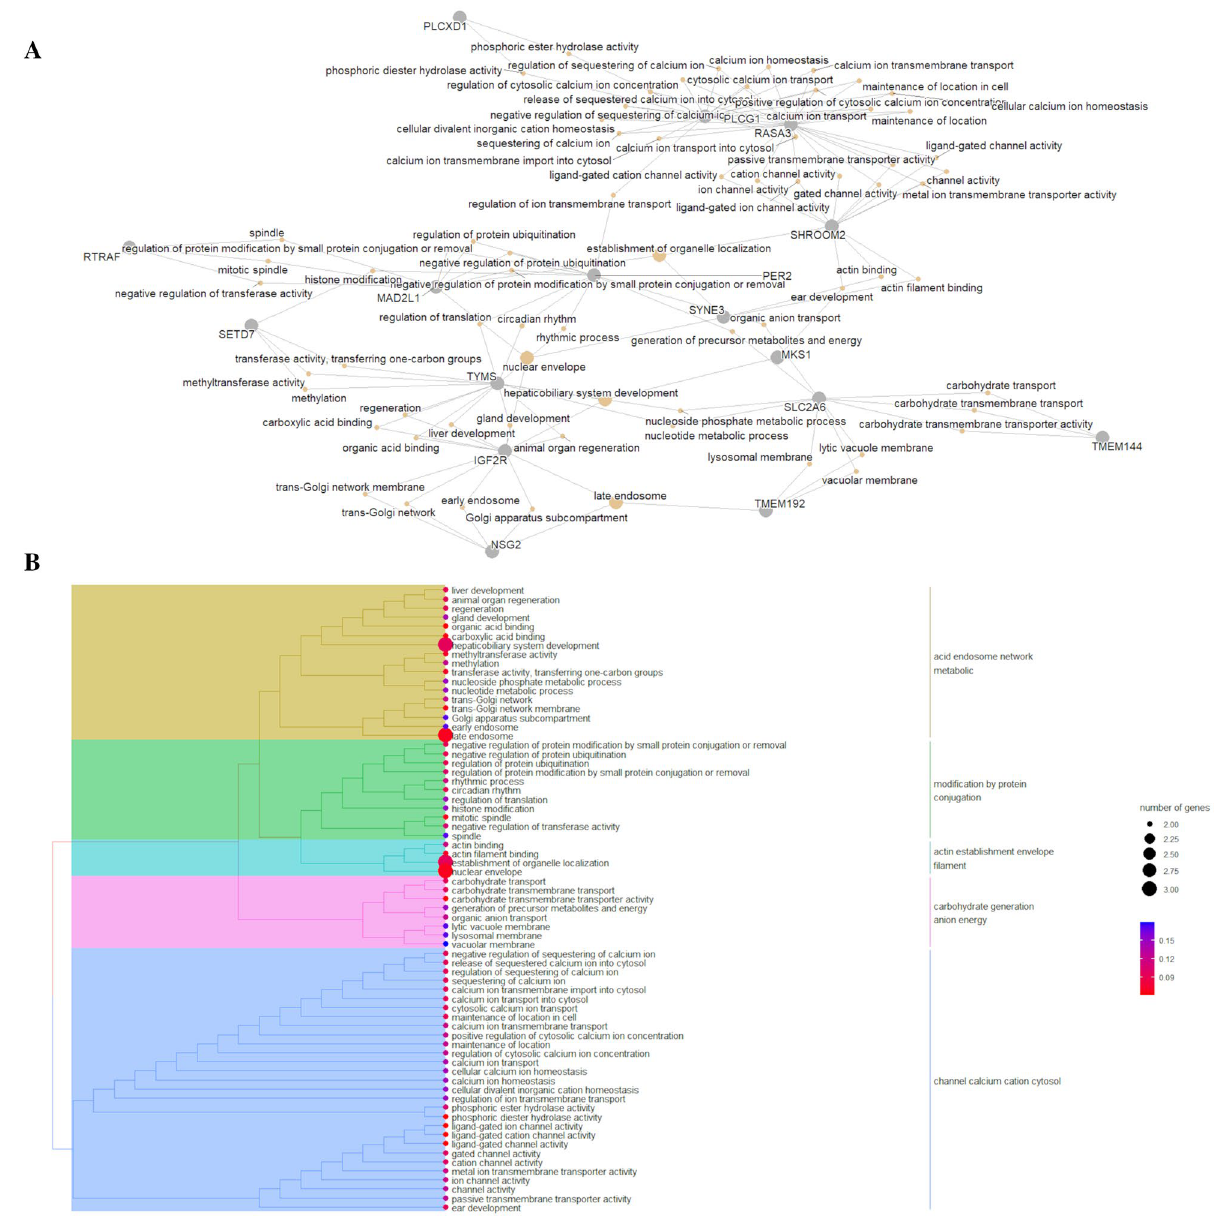
Figure 4. Functional analysis for the genes harboring differentially methylated regions for the FatGroup term of the multifactorial model. ( A ) Network composed of genes (gray circles) and gene ontology (GO) terms (yellow circles) showing the functional connection between the genes harboring DMRs identified for the FatGroup term. ( B ) Functional grouping tree diagram for the annotated GO terms. Each color in the dendrogram represents a functional group obtained after estimating the Jaccard correlation coefficient. The area of the circles represents the number of genes assigned to each GO term, and the color of the circle indicates the P value estimated for each GO